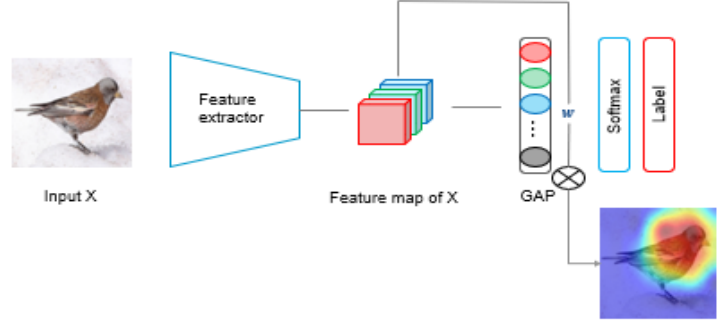
Figure 2. Network structure of Class Activation Map .